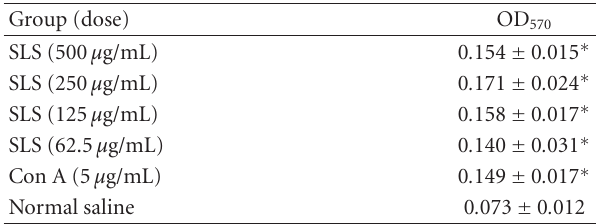
Table 1: Promotion of chicken PBMC proliferation by